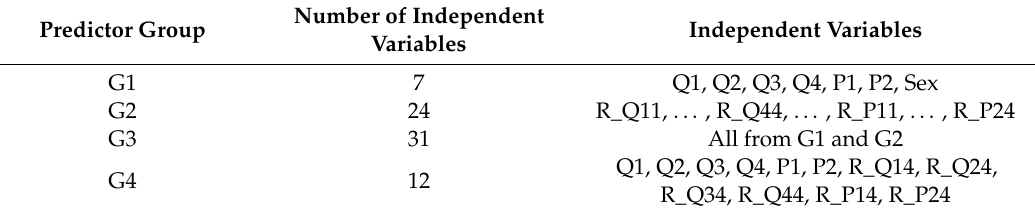
Table 4. Distribution of independent variables in CART models.